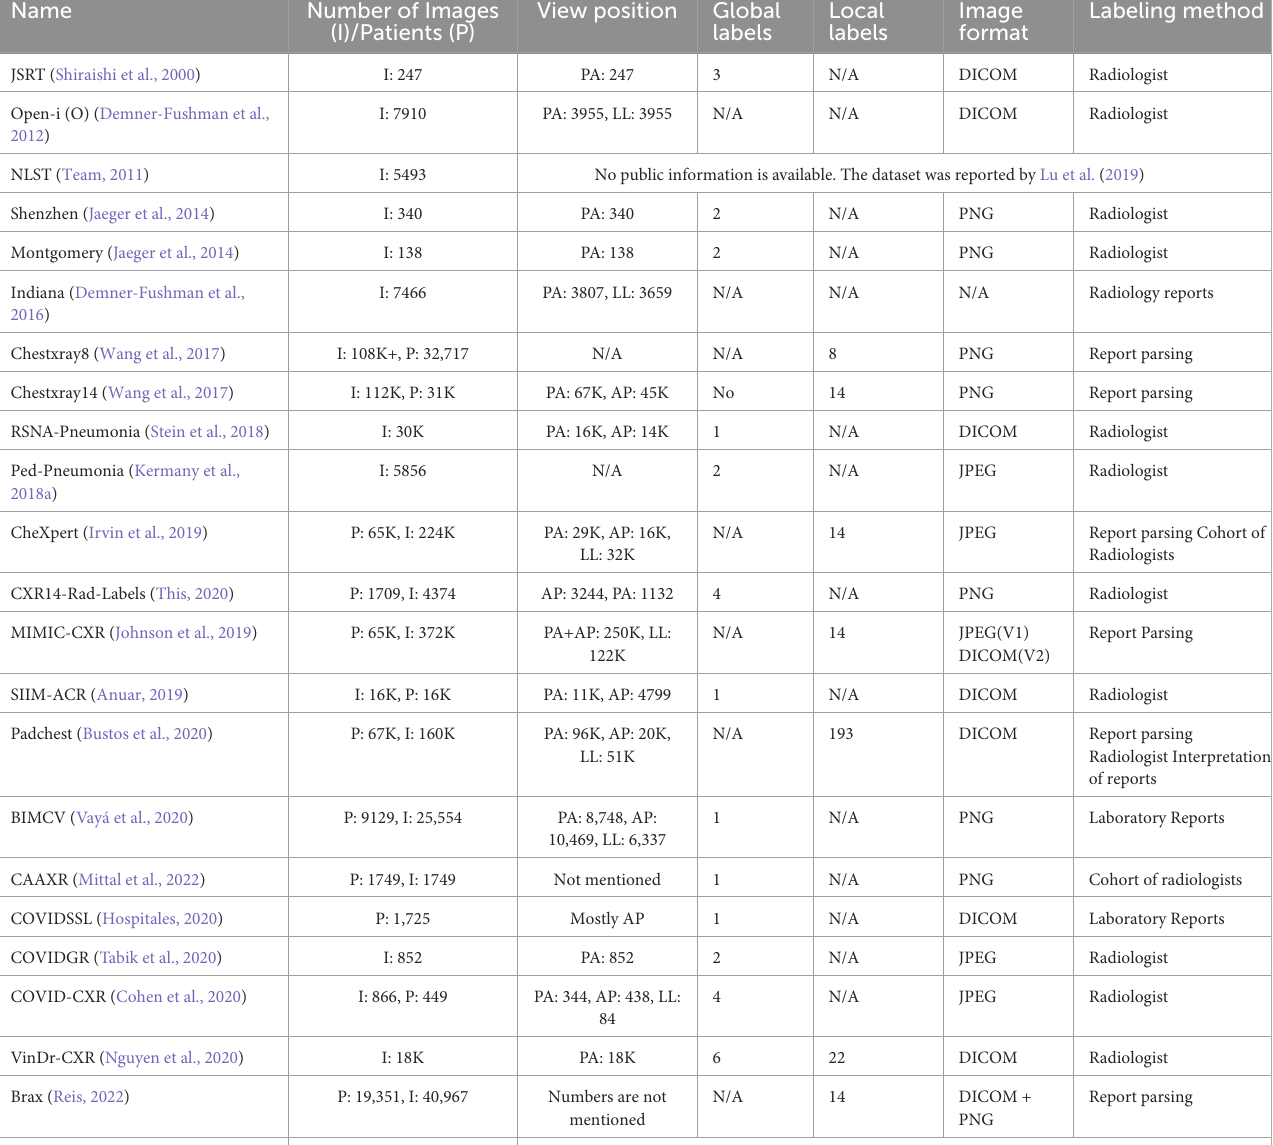
TABLE 7 Illustrates the available CXR datasets in the